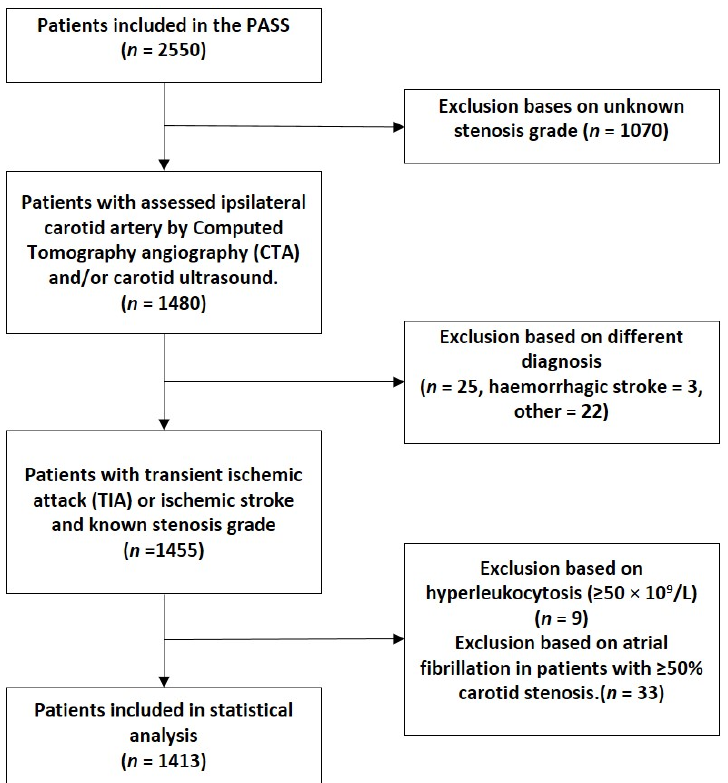
Figure 1. Flowchart of included